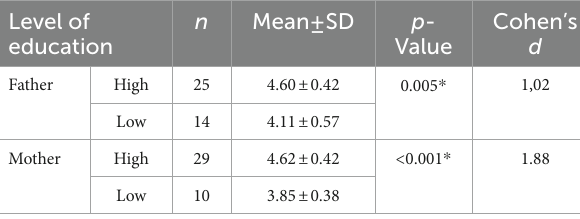
CLP, cleft lip and palate; CPO, cleft palate only; CL, cleft lip. TABLE 6 Parental level of education in relation to overall academic average of the cleft